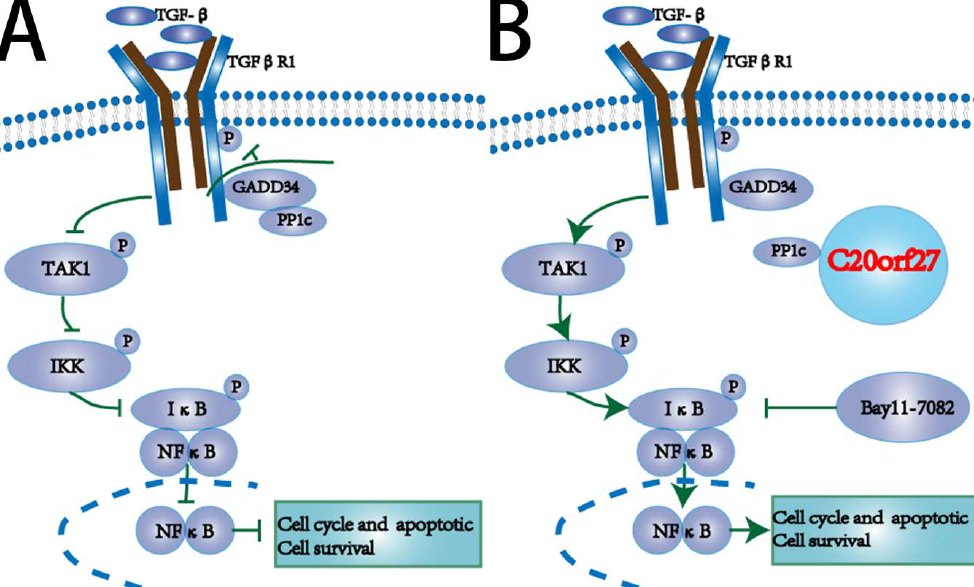
Figure 7. Schematic mechanism. ( A ) Binding of PP1c and GADD34 inhibits the TGFβR-TAK1-NF ĸ B pathway; ( B ) C20orf27 interacts with PP1c, releasing GADD34 to activate the TGFβR-TAK1-NF ĸ B pathway, promoting tumor growth in CRC.